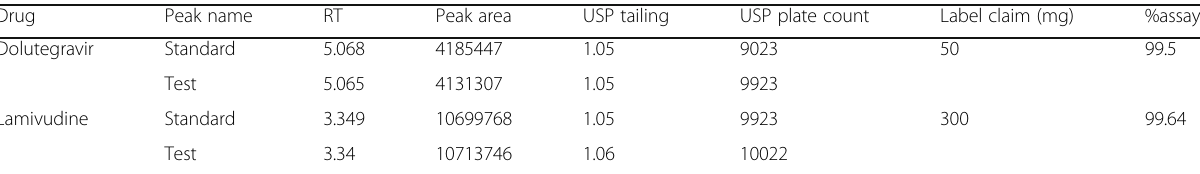
Table 8 Results of % assay of the tablet dosage form